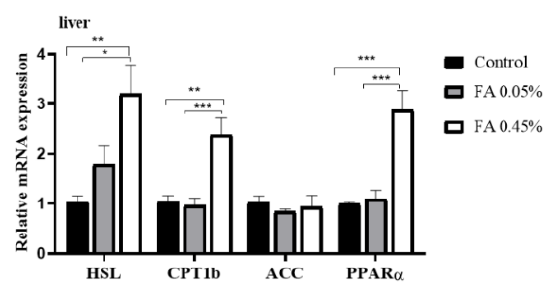
Figure 3. Liver lipid-metabolism-related gene expression. HSL , CPT1b , ACC, and PPARα mRNA levels in liver were measured by real-time quantitative PCR and normalized to the amount of GAPDH mRNA. Data were the mean and standard errors ( n = 6). * p < 0.05, ** p < 0.01, and *** p < 0.001.